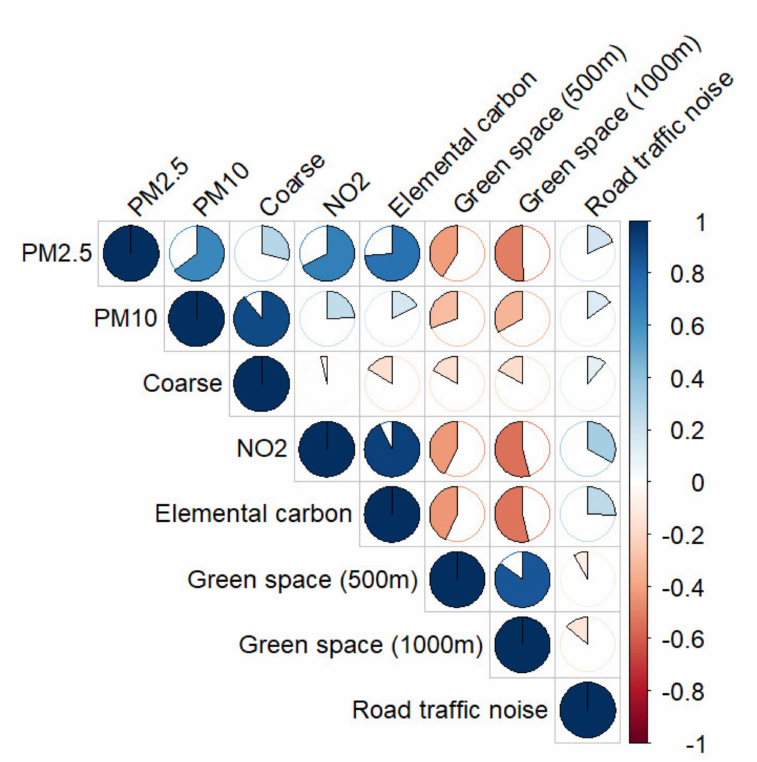
Figure 1. Spearman correlations between PM 2.5 , PM 10 , PM coarse , NO2, elemental carbon, green space (500 m and 1000 m buffer), and noise. Clockwise (blue) denotes positive correlations, counter clockwise (red) denotes negative correlations. N = 43.916